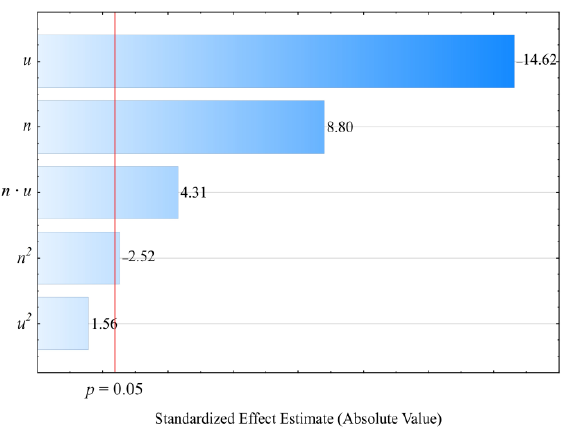
Figure 4. Pareto charts of the standardized effects for the empirical model M of the screw drive torque; the vertical line in the plot corresponds to the arbitrarily chosen level of significance ( p = 0.05).